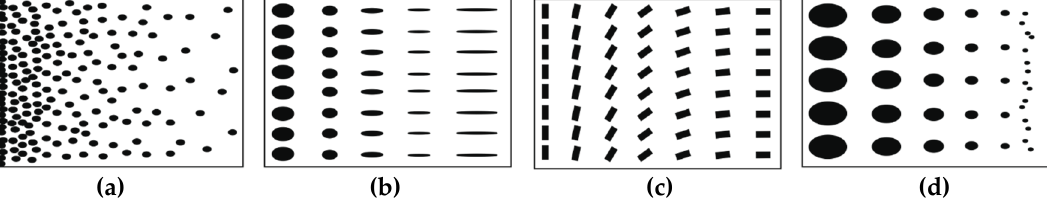
Figure 2. Different types of functionally graded materials based on nature of gradients: ( а ) fraction gradient type; ( b ) shape gradient type; ( c ) orientation gradient type; ( d ) size gradient type.